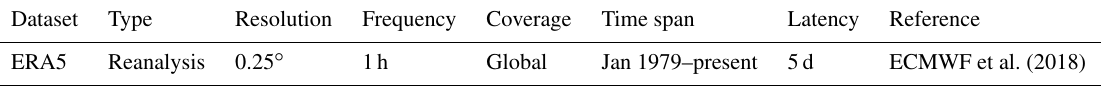
Table 2. Main features of the selected soil moisture dataset. Dataset